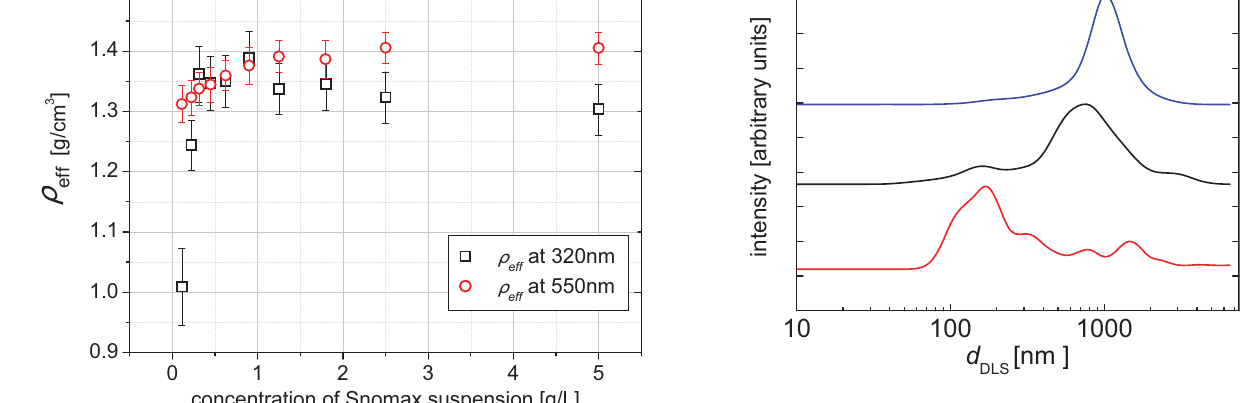
Figure 4. Size distributions of the particulate matter present in Sno- max suspensions as measured with DLS. The blue curve represents the size distribution seen in a freshly produced Snomax suspension, the black and red curve show size distributions as present in parti- cles after dispersion with a nozzle spray disperser or an atomizer,